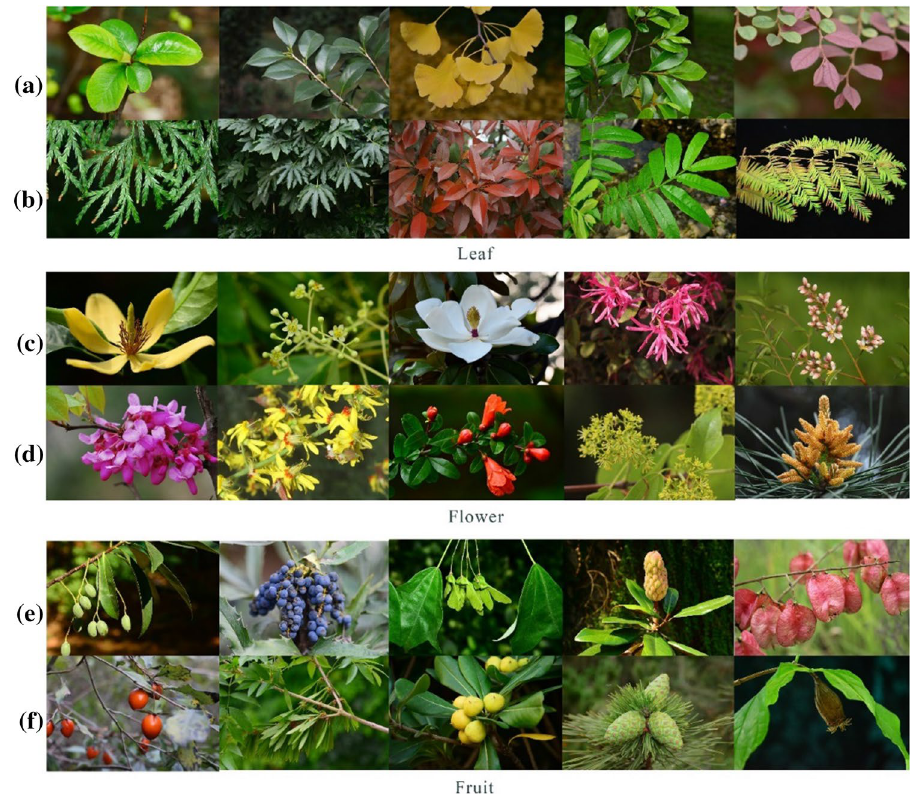
Figure 1. Examples of plant pictures used in the eye-tracking experiment: ( a , b ): leaf; ( c , d ): flower; ( e , f ): fruit. All pictures were taken by the project researcher or downloaded from the Institute of Botany, Chinese Academy